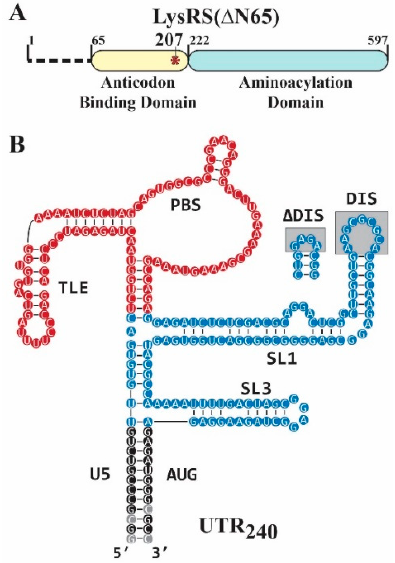
Figure 1. Proteins and RNAs used in this study. ( A ) The 532-residue human LysRS construct used for all experiments lacks the N -terminal 65 residues (LysRS( ∆ N65)). The phosphomimetic mutant replaces a serine at position 207 with an aspartate in the anticodon binding domain (S207D, red asterisk). ( B ) The UTR 240 construct contains the U5/AUG stem (black), PBS/TLE domain (red, nt 126–224), and Psi domain (blue, nt 117–125 and 225–332). The gray boxed regions indicate the mutation that was made to replace the DIS with a stable GNRA tetraloop ( ∆ DIS). The PBS/TLE domain was also deleted for some studies ( ∆ PBS/TLE) and replaced with GAGA. Nt in gray circles indicate mutations that were made to promote transcription efficiency and stabilize the terminal stem, as described in the Methods. The secondary structure shown is based on Ref